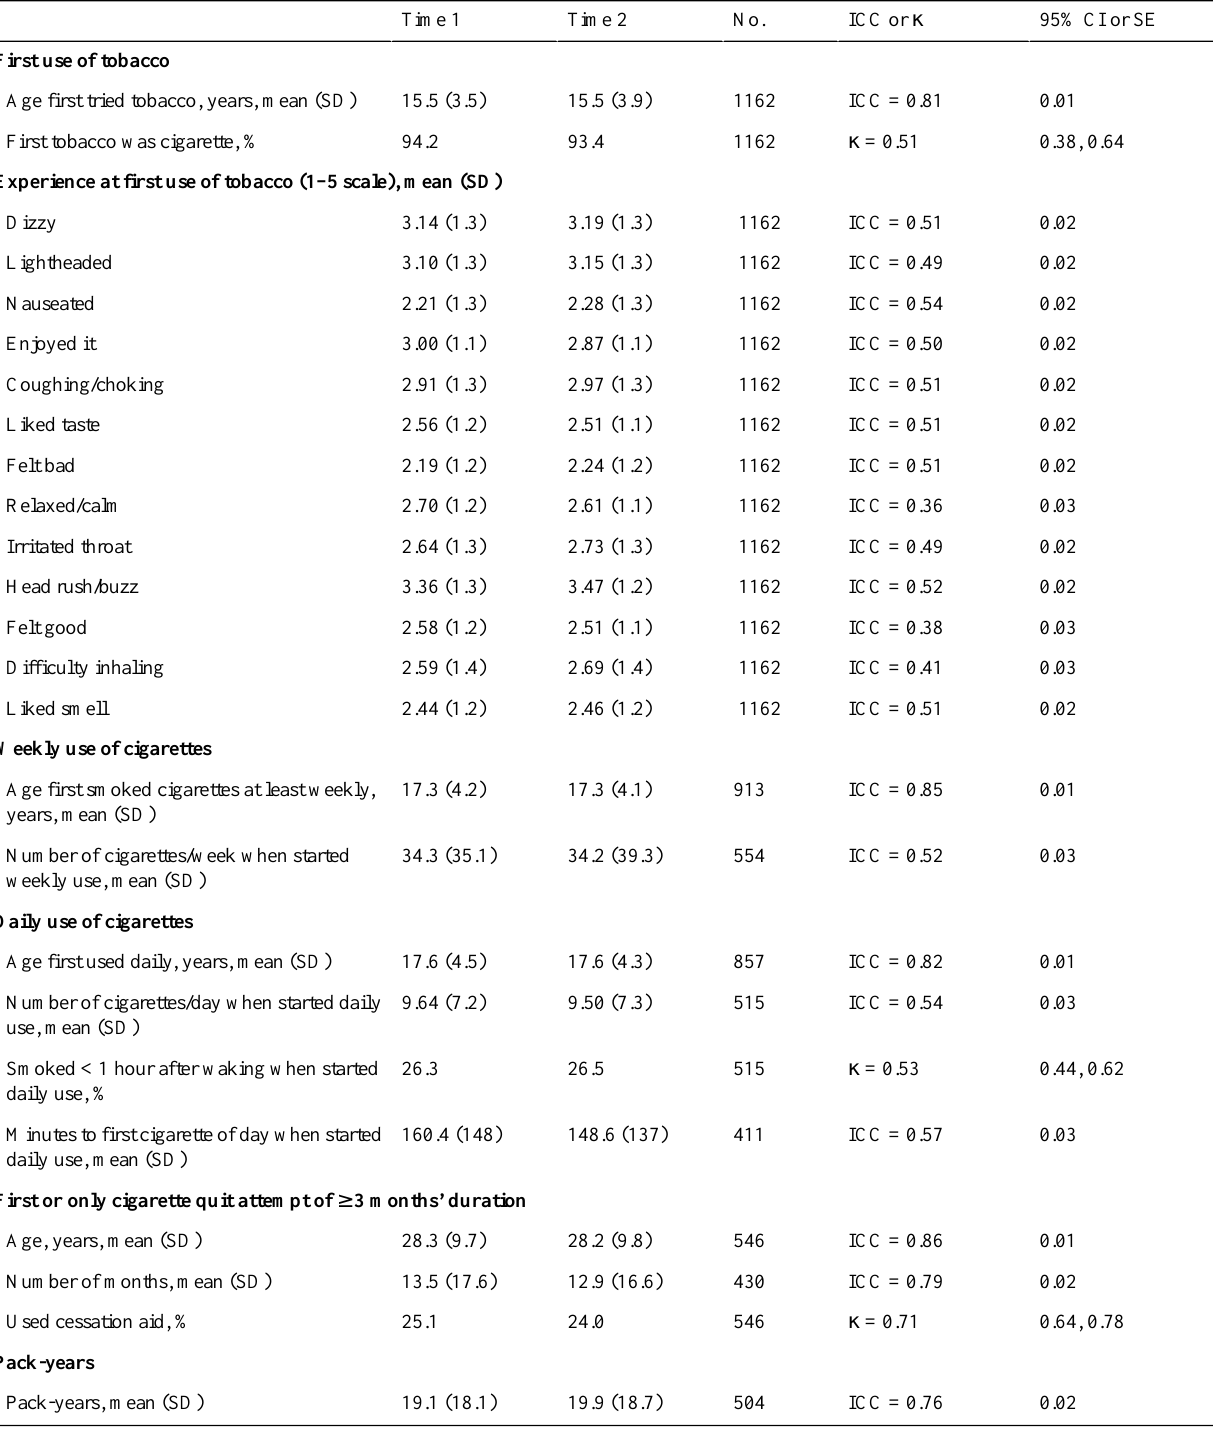
Table 2. Test-retest reliability of self-report details of tobacco use